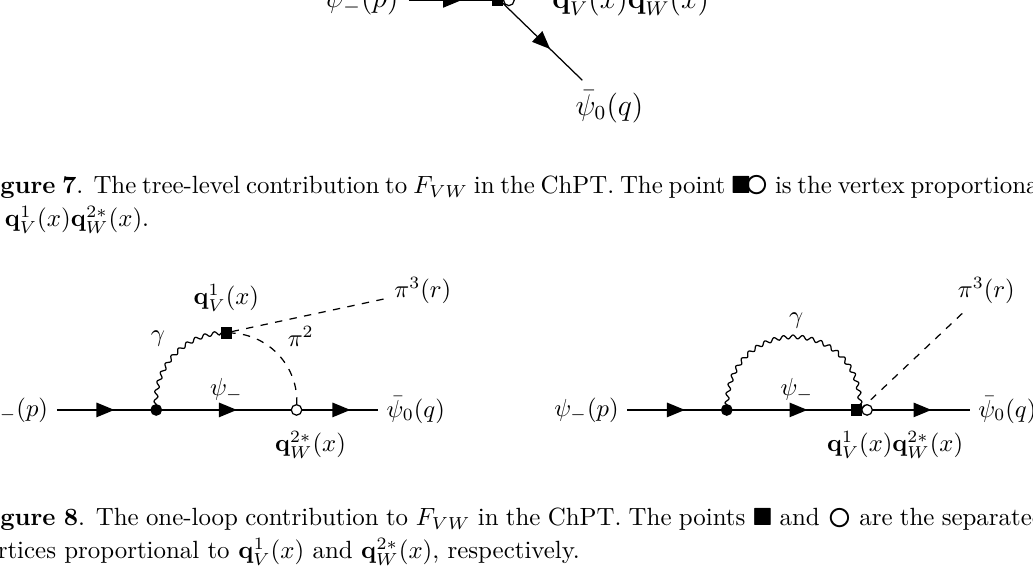
( x ) and q 2 ∗ ( x ) , V W